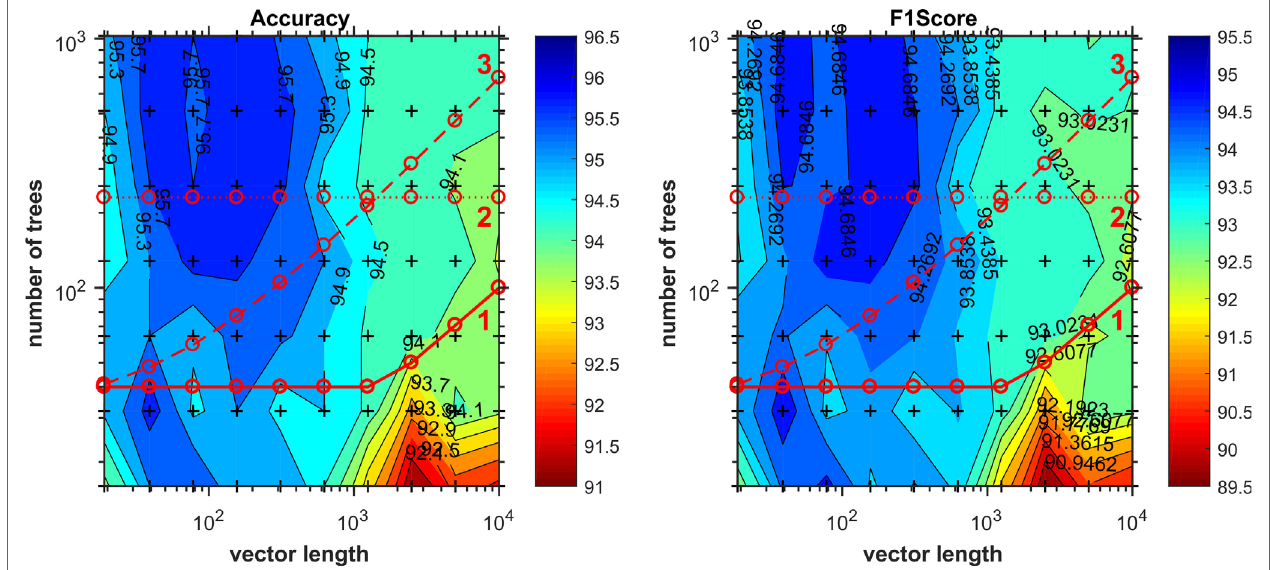
FigUre 1 | Number of trees given by grid search as function of vector length. Cross marks inside the chart denotes values evaluated during the grid search. Lines 1, 2, and 3 correspond to functions as expressed in Table 2 used to compute the number of trees on the evaluation of discriminant features